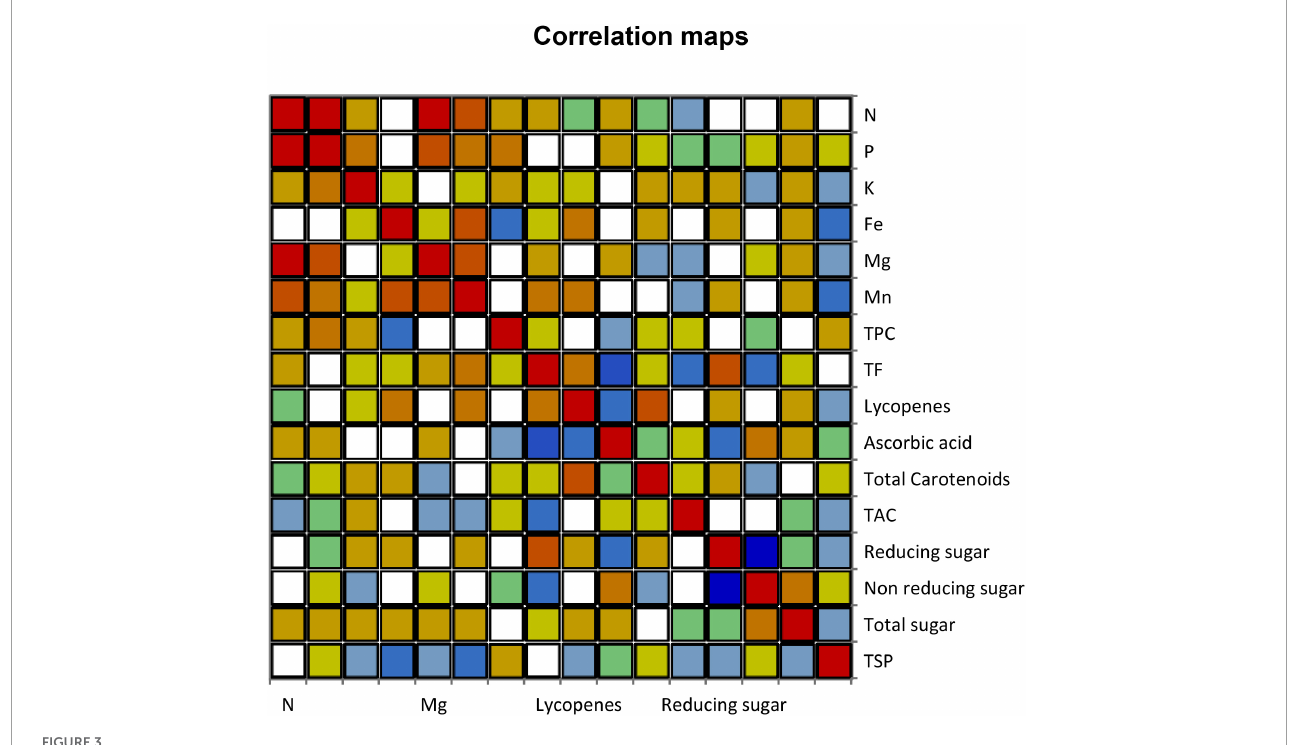
FIGURE3 Correlation maps of various fruit peel